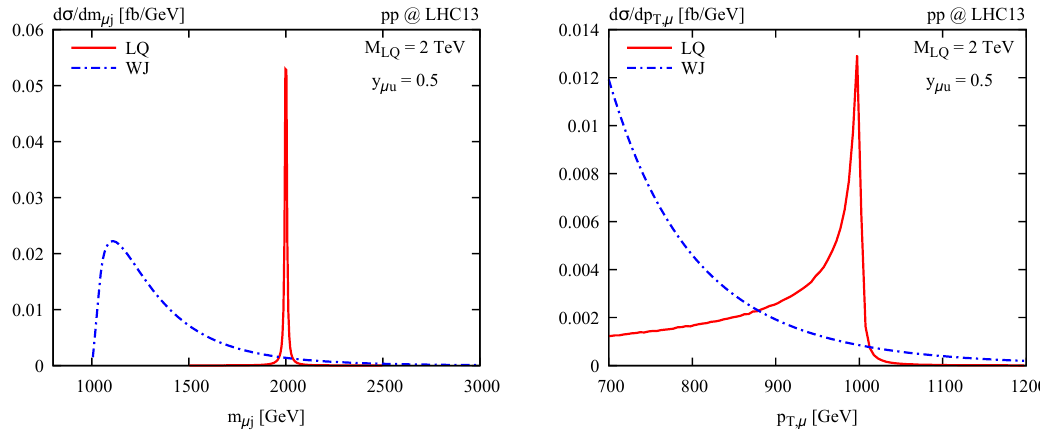
Figure 12. Invariant mass (left) and muon transverse-momentum (right) distributions of the muon+jet system. The signal (red line) is due to a LQ of mass M LQ = 2 TeV and Yukawa coupling y LQ = 0 : 5 in the hypothesis of minimal coupling of the LQ between (cid:12)rst-generation quarks and second-generation leptons. W ( l(cid:23) ) + 1 jet background is shown in blue. Selection cuts: p T;‘ ; p T;j > 500 GeV, j (cid:17) ‘ j ; j (cid:17) j j < 2 : 5 and p T; miss < 50